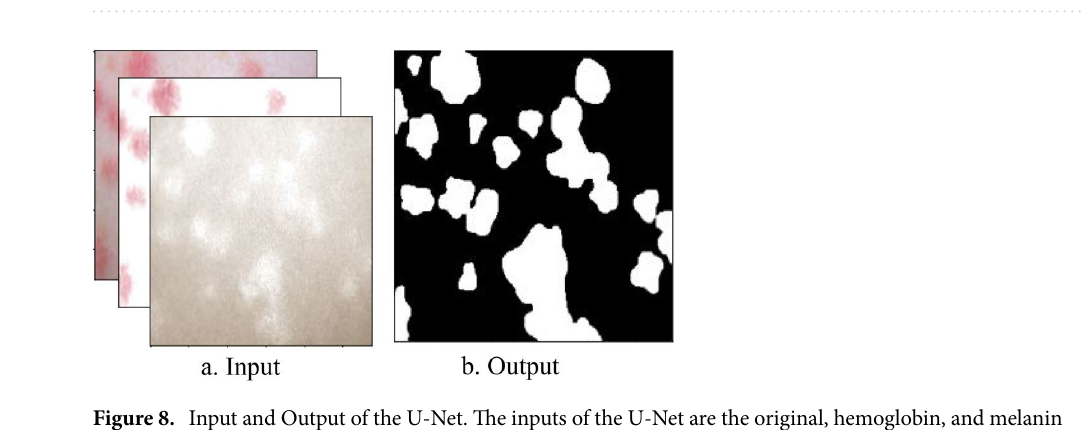
Figure 7. U-Net architecture. A fully CNN network, comprised of down-sampling, up-sampling, and skip connections 17 .